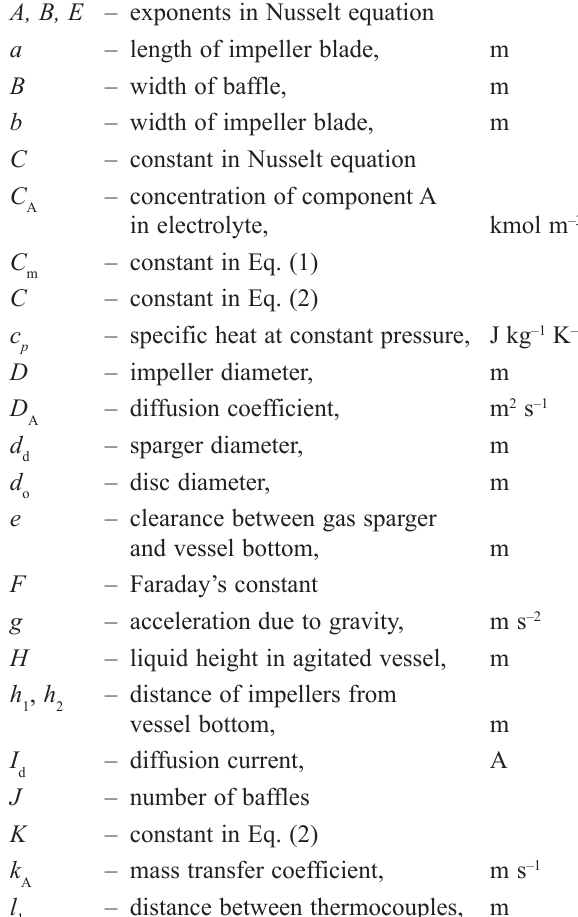
Fig. 13 – Comparison of the C mentally and calculated from Eqs. (13) – (21) for gas – liquid systems; a) turbulent range of the flow (liquid phase: distilled water; 30 % aqueous solution of glucose, electrolyte); b) tran­ sitional range of the flow (liquid phase: